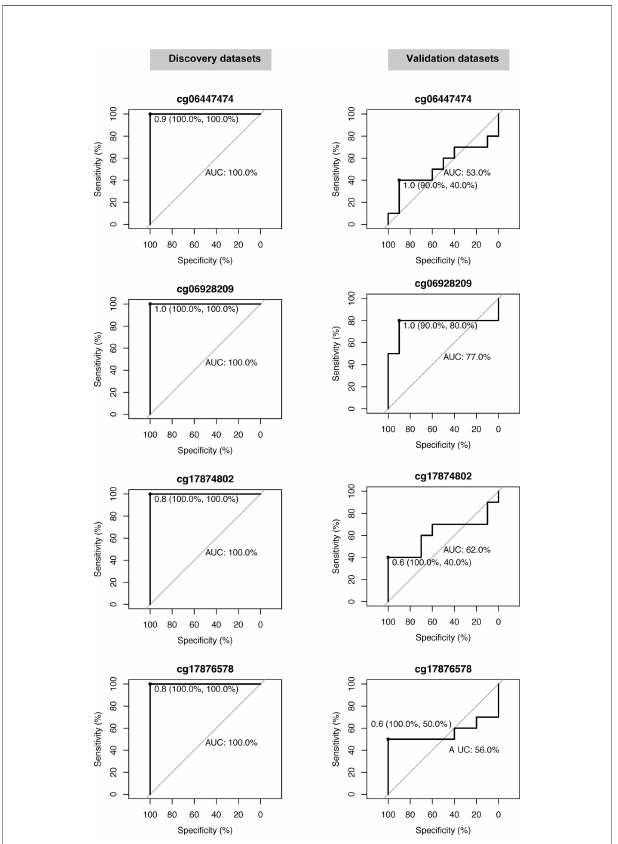
FIGURE 4 | Validation of the diagnostic performance of four selected DNA methylation sites in the validation dataset. Receiver operating characteristic curve (ROC) analysis was conducted on this dataset. Area under the curve (AUC), speci fi city, and sensitivity are calculated and displayed for each